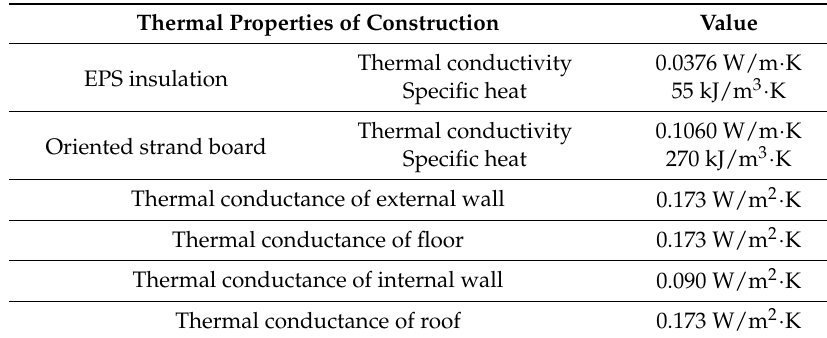
Table 2. Specification of sensors and equipment for the experiment.